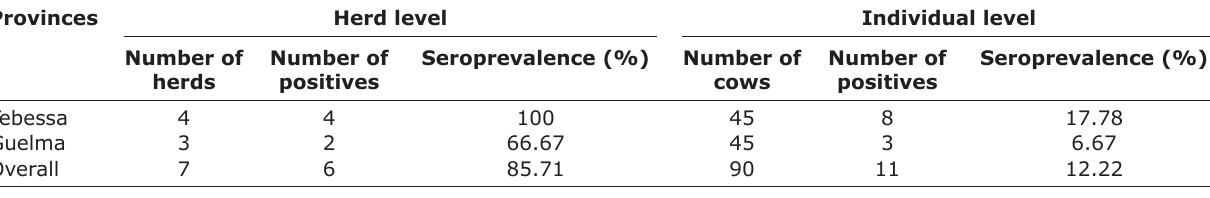
Table-1: Seroprevalence (%) of Neospora caninum infection at individual and herd levels. Provinces Herd level Individual level Number of